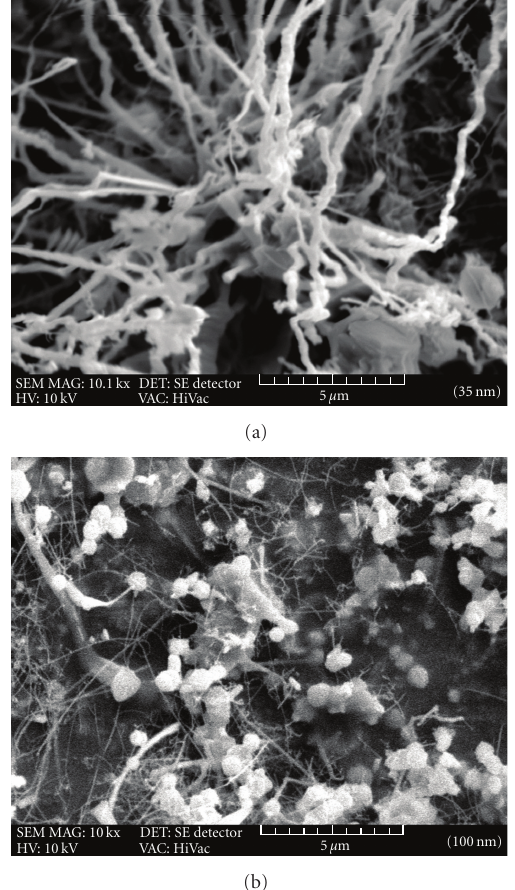
Figure 8: The residues of the 35nm and 100nmAl powders after the